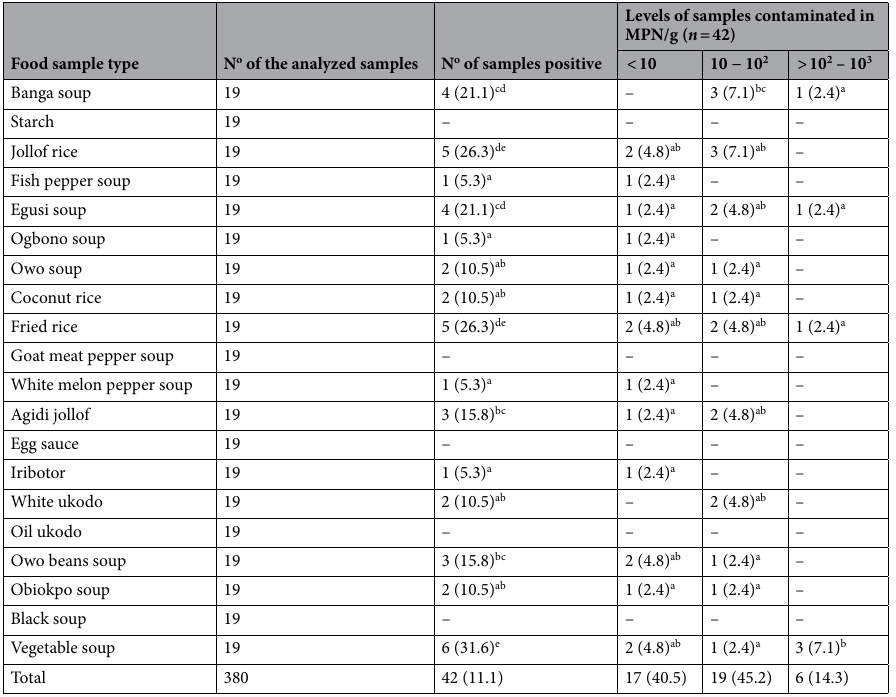
Table 1. Prevalence levels of V. parahaemolyticus contamination from RTE foods. Values with statistical differences carry different alphabets across